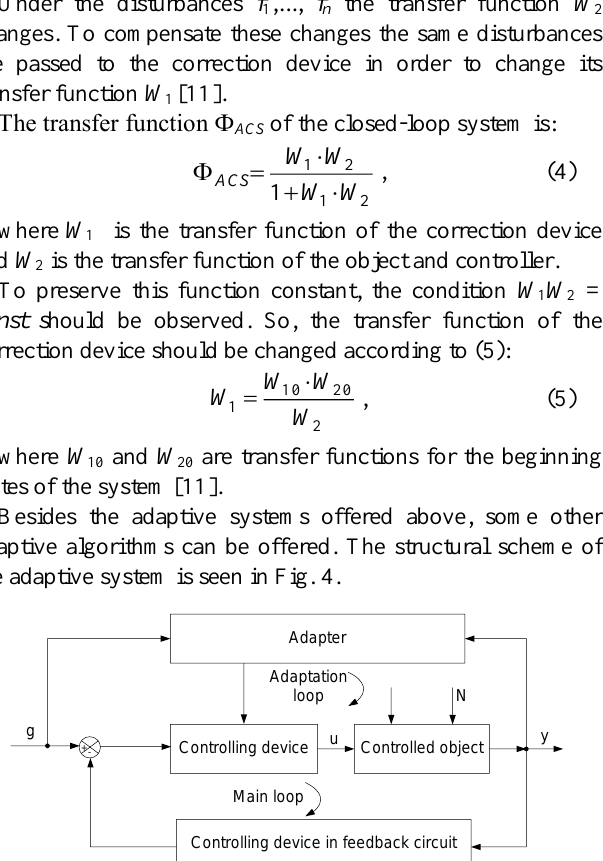
Fig. 4. Structural scheme of adaptive